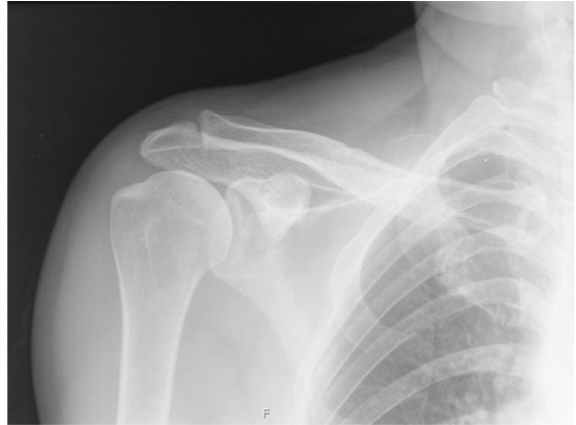
Figure 1: Anteroposterior radiograph of the right shoulder. The radiograph is normal.